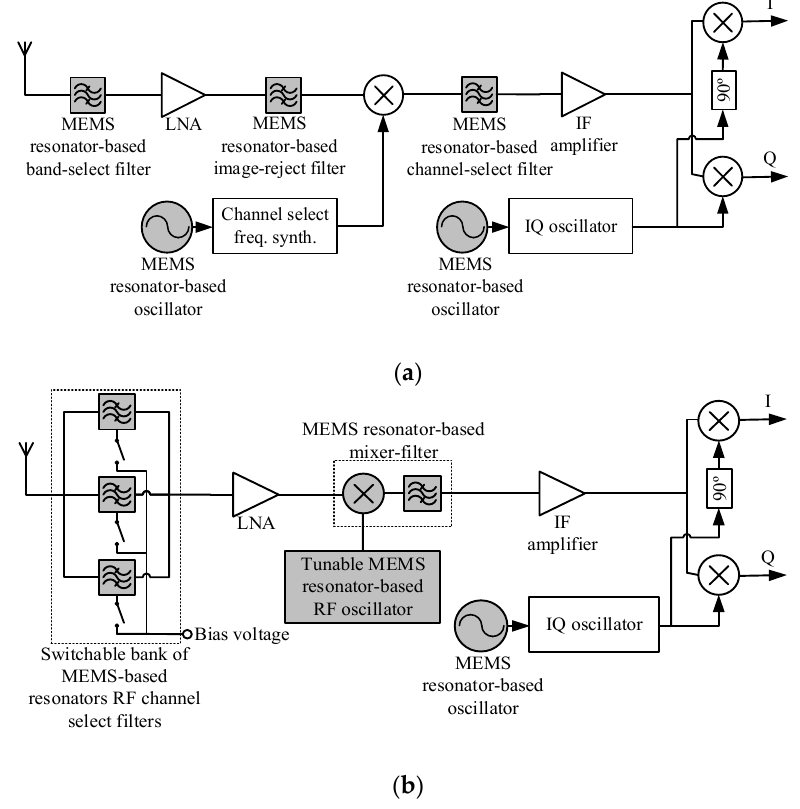
Figure 39. ( a ) Super-heterodyne architecture with off-chip components replaced by integrated MEMS resonators; and ( b ) a resonator-based receiver architecture.